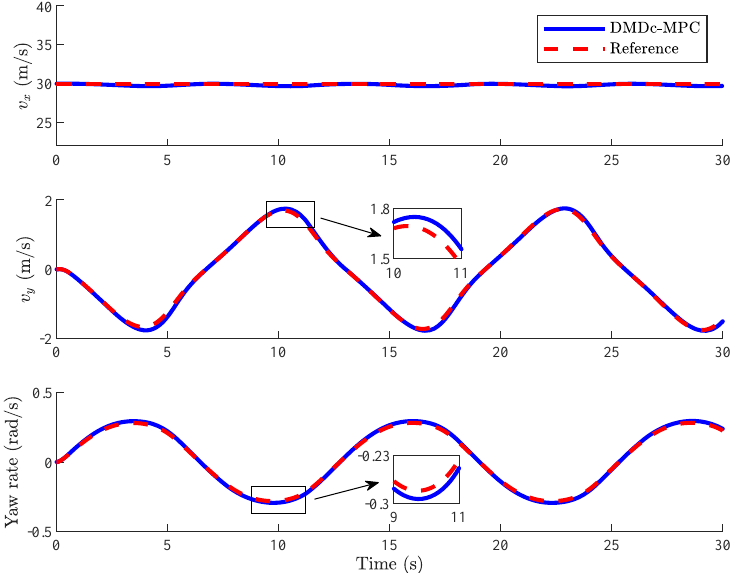
Figure 15. State evolution of DMDc-MPC (Case 3).